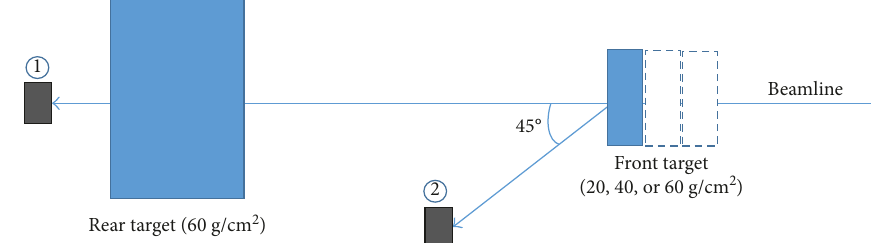
Figure 3: ∆ E / ∆ E detection system arrangements.